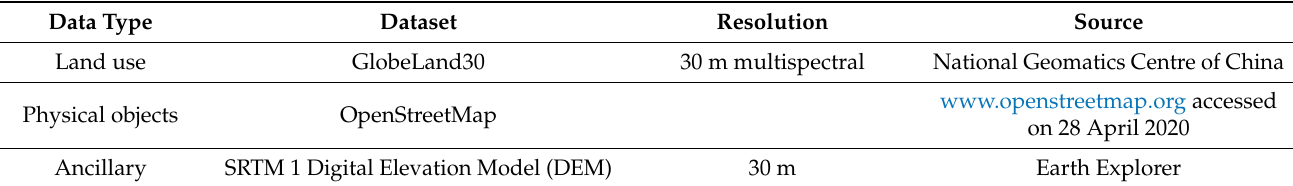
Table 2. Description of the collected remotely sensed and geospatial data.